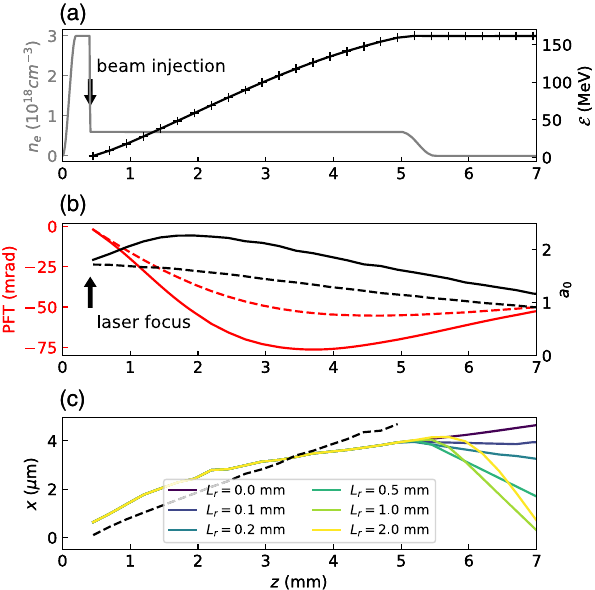
FIG. 3. (a) Plasma density profile and energy of the electron beam trapped at z ≃ 400 μ m. (b) Evolution of laser properties. The τ ¼ 20 fs pulse is focused to w 0 ¼ 30 μ m at the end of the ¼ 410 μ m, reaching a ¼ 1 . 77 . Pulse front tilt is down ramp z 0 f introduced with angular chirp only, with ζ ¼ 0 . 2 mm fs. Dashed (solid) lines show vacuum (plasma) propagation. (c) Transverse position of the electron beam upon propagation, for various FIG. 4. (a) Final angular profile of the accelerated electron lengths of the final down ramp. The dashed line shows model beam, for three values of the down ramp length. (b) Beam final predictions for x [Eq. (4)]. Eq direction as a function of the ramp length. Vertical bars show the beam width (standard deviation) in x . The inset is an enlargement ofthe first three points, without error bars. (c) Final beam angle as a ¼ 0 . 1 mm) function ofspatial chirpat focus ζ forcorrecting( L ramp ¼ 0 . 5 mm) lengths. (d) Final beam and noncorrecting ( L ramp angle as a function of ramp length L . For this subplot only, ramp the low-density plateau was shortened (see the main